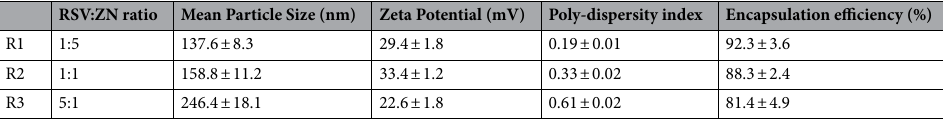
Table 1. Particle size, zeta potential, polydispersity index and encapsulation efficiency of ZN-RSV NPs formulae.